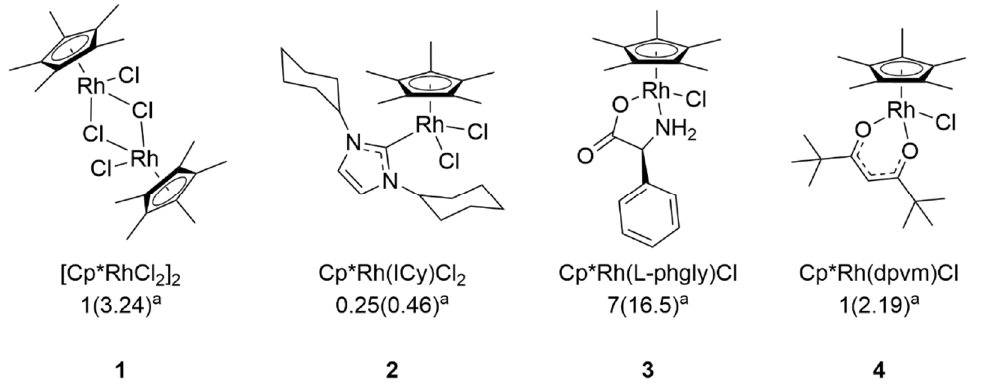
Figure 1. Organometallic complexes investigated for virucidal activity against SARS-CoV-2. a Min- imum inhibitory concentration (MIC) as reported previously and given in µg/mL (µM) against My- cobacterium smegmatis , which is commonly used as a model organism for more pathogenic strains of mycobacteria, including M. tuberculosis [39]. Cp* = pentamethylcyclopentadienide; ICy = 1,3-dicy- clohexylimidazol-2-ylidene; phgly = phenylglycinato; dpvm = dipivaloylmethanato.